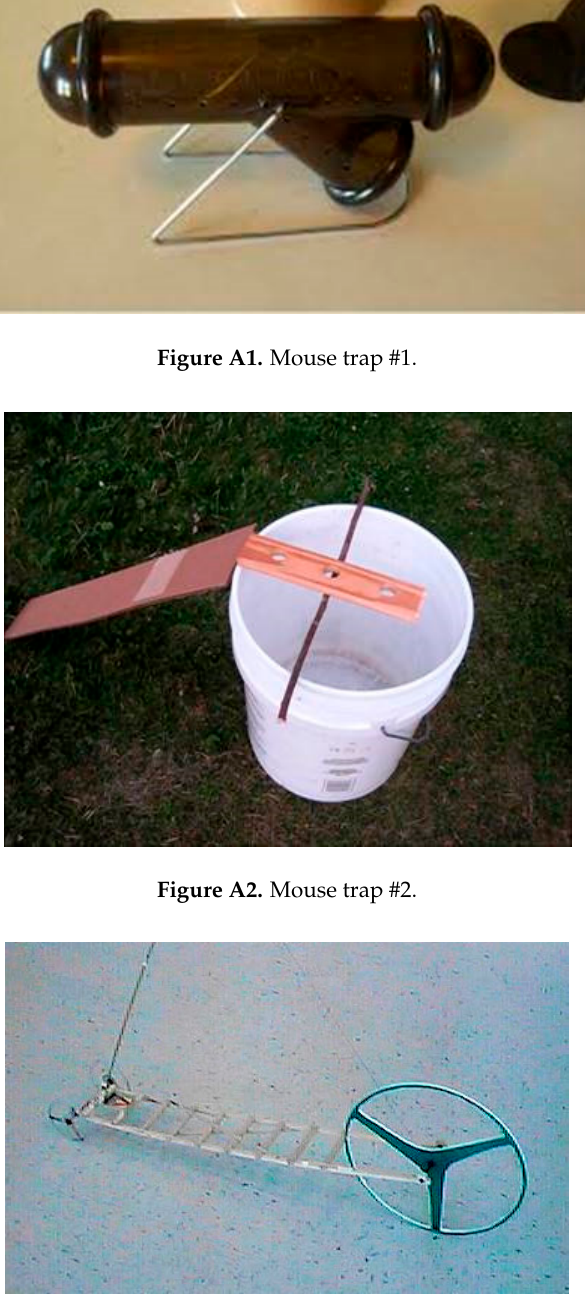
Figure A3. Mouse-propelled transport.